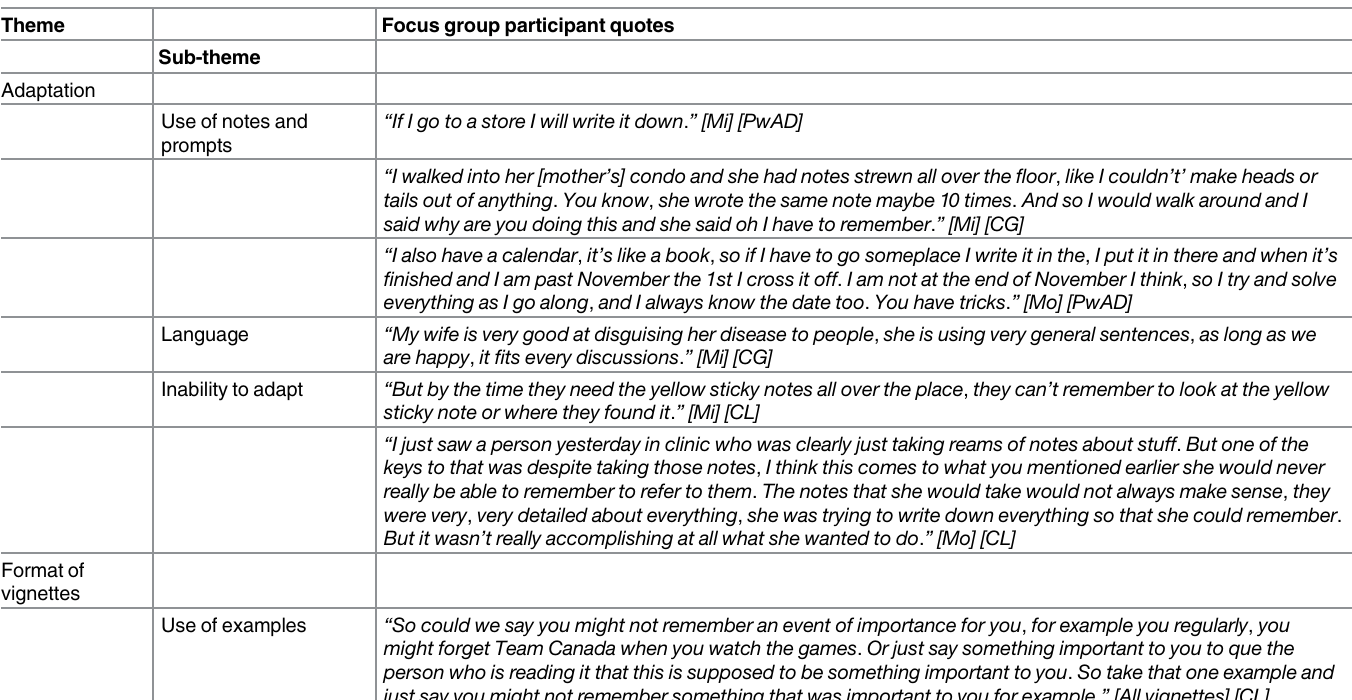
Table 3. Focus group themes and